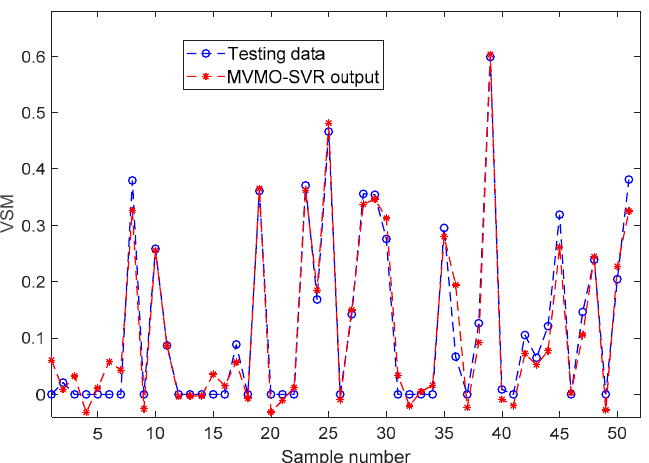
Figure 10. Comparison between actual and predicted values of VSM with MVMO-Support Vector Regression (SVR).